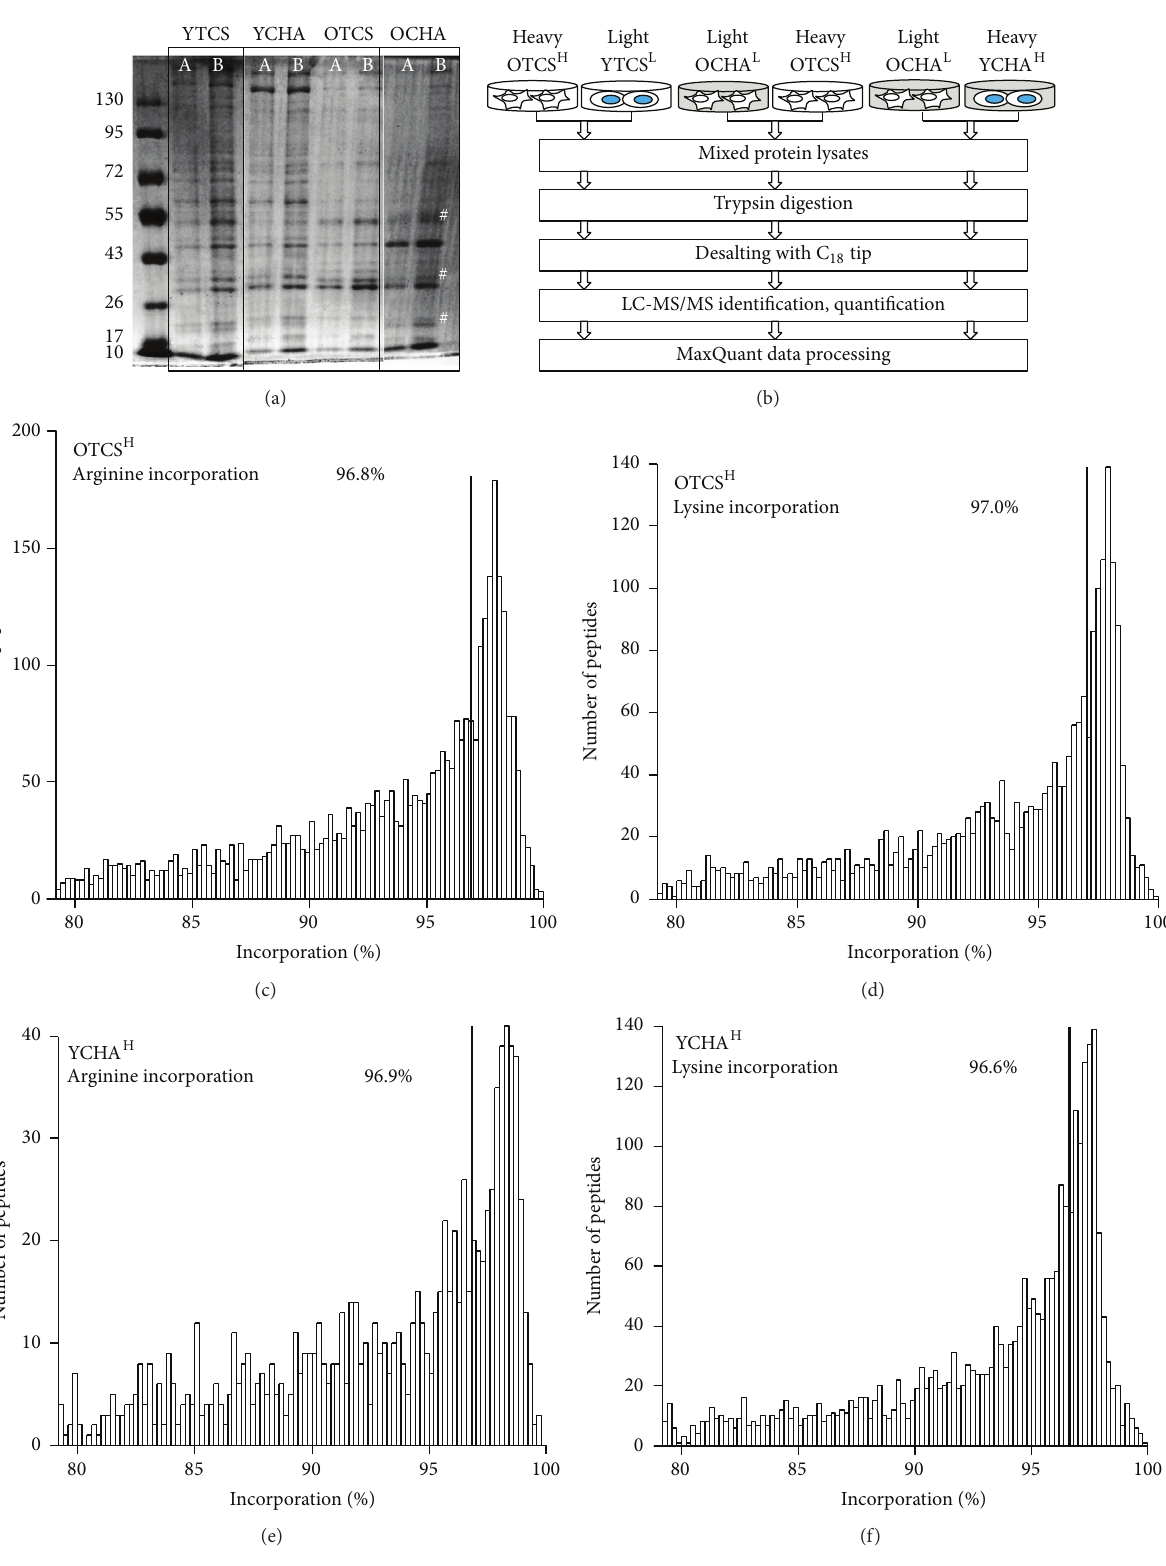
Figure 2: Proteomic workflow and incorporation rate of SILAC-labeled PDMSC. (a) The protein lysates collected at P5 and P17 for PDMSC cultured on TCS and CHA were separated on 8% SDS gel and stained with coomassie blue. The amounts of protein loaded were 10 𝜇 g (Lane A) and 30 𝜇 g (Lane B), respectively, for YTCS, YCHA, OTCS, and OCHA. The symbol (#) represents varied protein bands in the OCHA (Lane B) compared to OTCS (Lane B). (b) The illustration shows experimental workflow. (c-d) Heavy amino acids incorporation for OTCS H after 5-6 doublings. (e-f) Heavy amino acids incorporation for YCHA H after 5-6 doublings. Incorporation efficiency of the heavy arginine and lysine for PDMSC were determined before further protein identification and quantitation analysis using